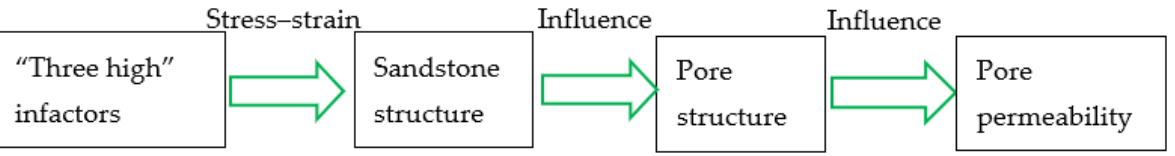
Figure 16. Influence mechanism of the “ three-high ” factors on sandstone pore